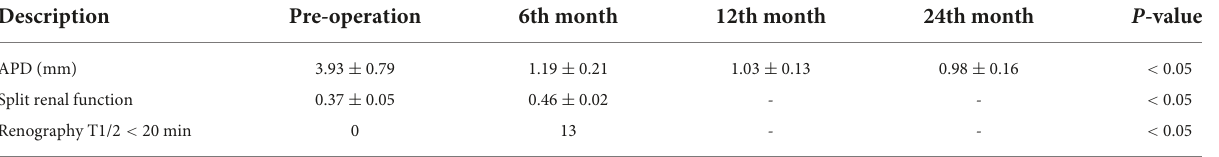
TABLE 3 Preoperative and follow-up